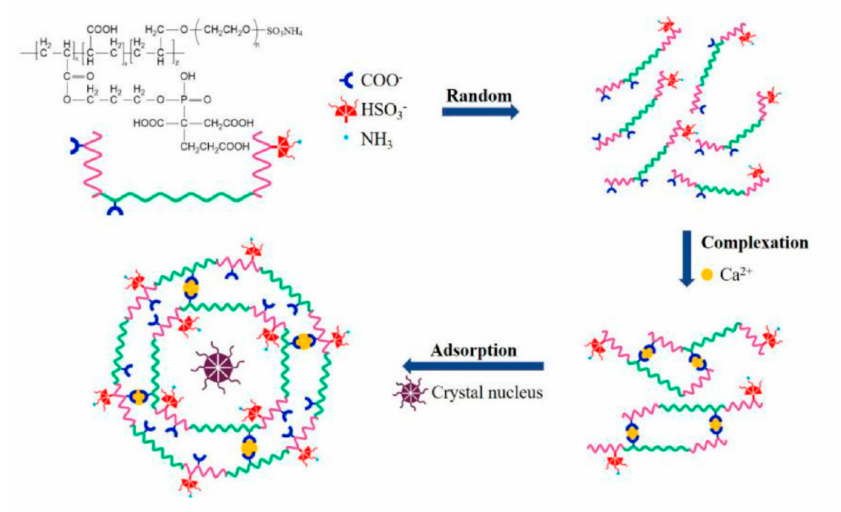
Figure 13. Schematic diagram of AA − APES − HPAY inhibition on calcium scales